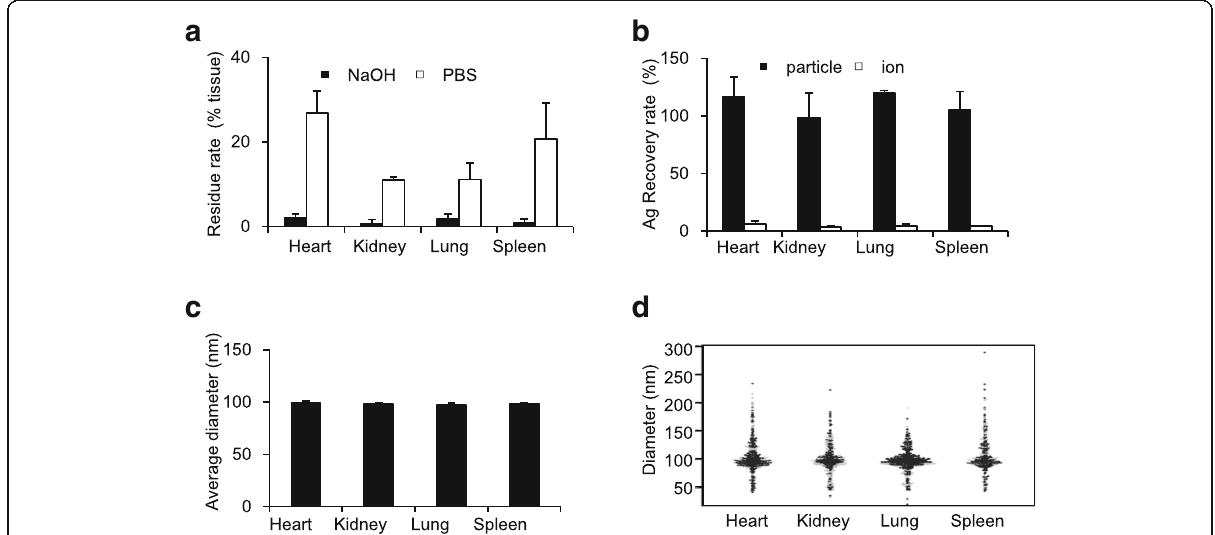
Fig. 3 NaOH pretreatment is the optimal method for detecting nAg100 in various organs. As in Fig. 2, the heart, kidney, lung and spleen homogenates were mixed with nAg100 and incubated with NaOH solution. After 3 h, a residue rates (black and white bars represent the residue rates in NaOH- or PBS-treatment, respectively), b recovery rates (black and white bars represent the rate of Ag detected as particles and as ions, respectively), c average particle diameters shown in a beeswarm chart, and d particle size distribution shown in a beeswarm chart were analyzed by sp-ICP-MS analysis in each tissue sample. The results are expressed as mean ± SD ( n =